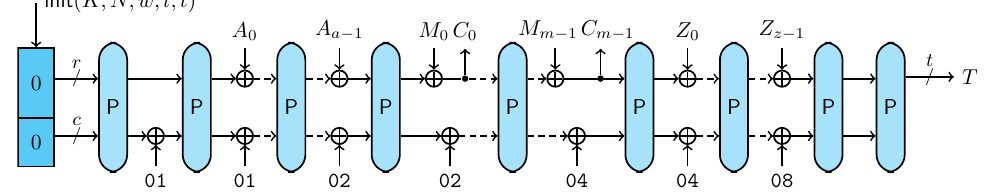
Figure 1: NORX v2.0 mode: the padded bit-strings of 12 w -bit blocks A = A 0 || · · · || A a − 1 , M = M 0 || · · · || M m − 1 and Z = Z 0 || · · · || Z z − 1 are processed by the monkeyDuplex